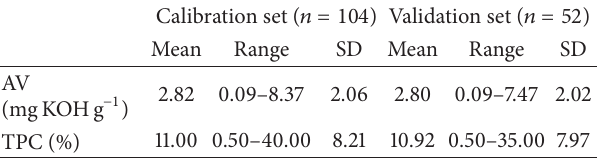
Table 1: Characteristics of reference data for calibration and validation sets.